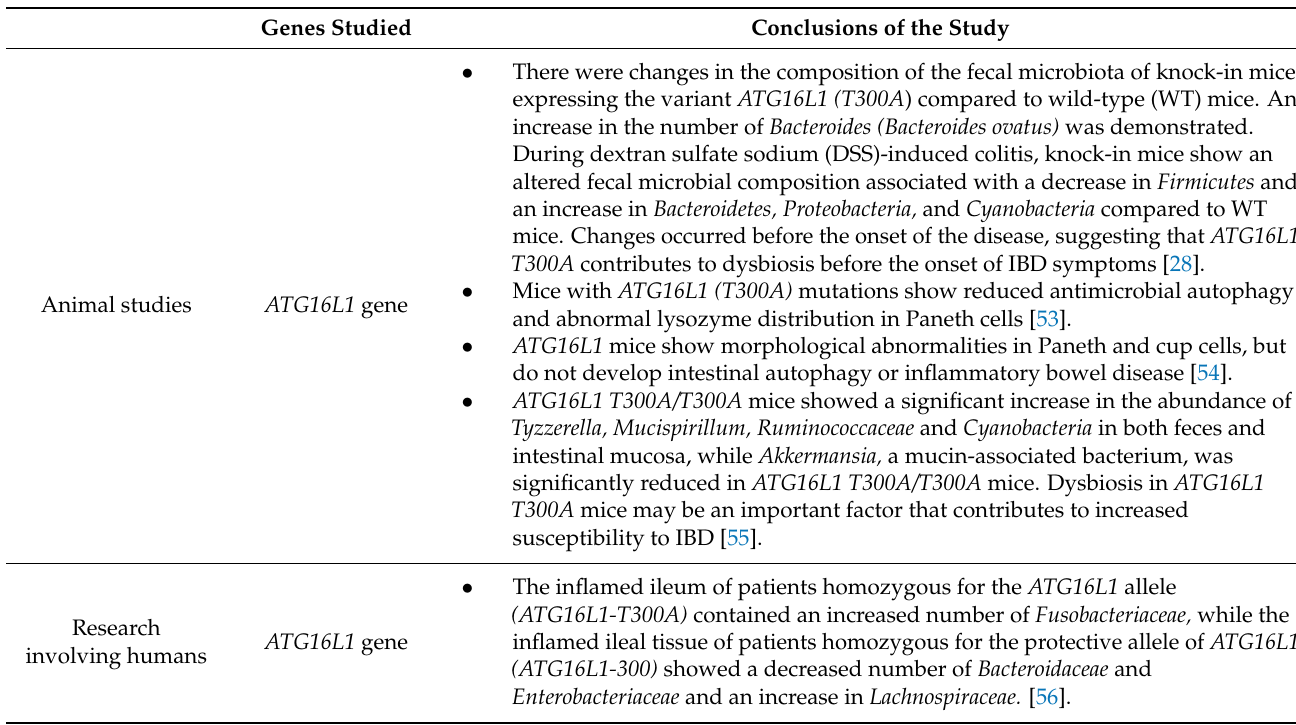
Table 2. The ATG16L1 gene mutation and its impact on the microbiota in IBD. Genes Studied Conclusions of the